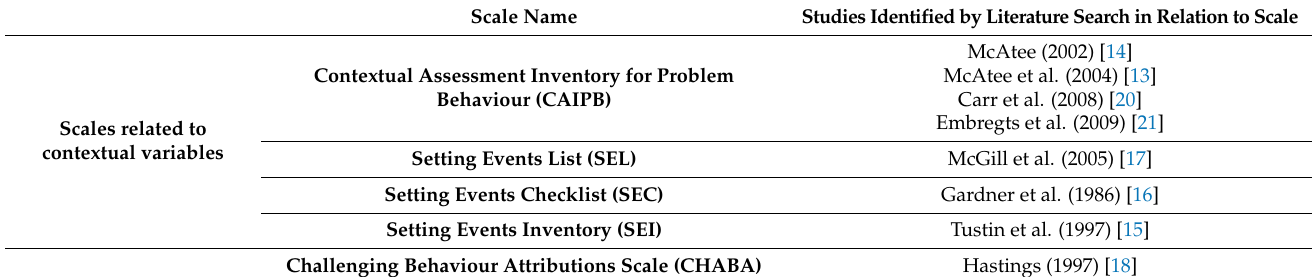
Table 1. Scales and studies identified in the literature